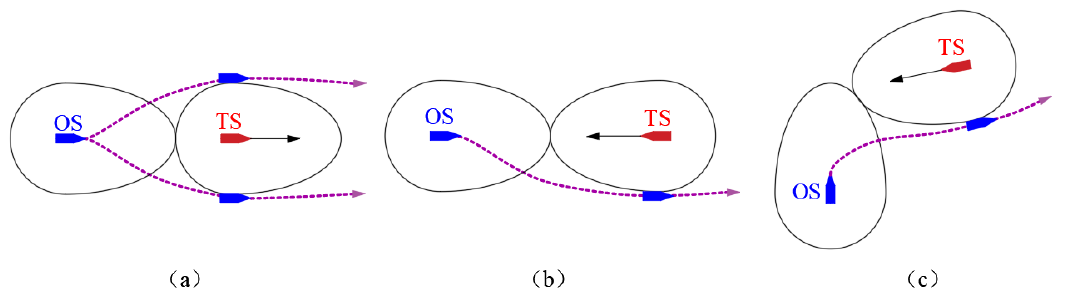
Figure 5. DNSD-based collision avoidance regarding COLREGs for different encounter situations: ( a ) overtaking; ( b ) head − on; ( c )